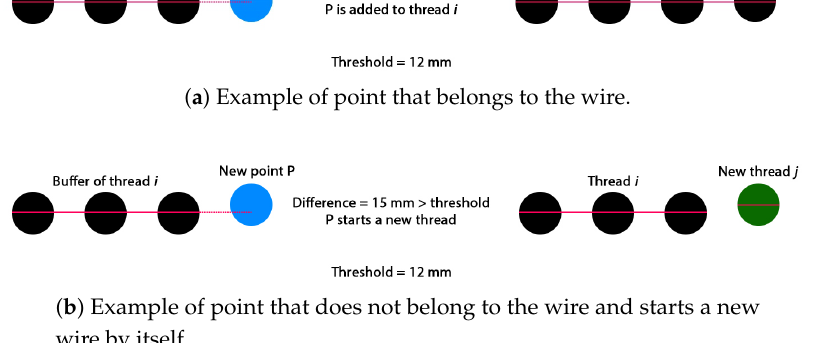
Figure 6. Check performed by the algorithm to label the current point analysed as belonging to that wire or not. ( a ): point that belongs to the wire; ( b ): point that does not belong to the